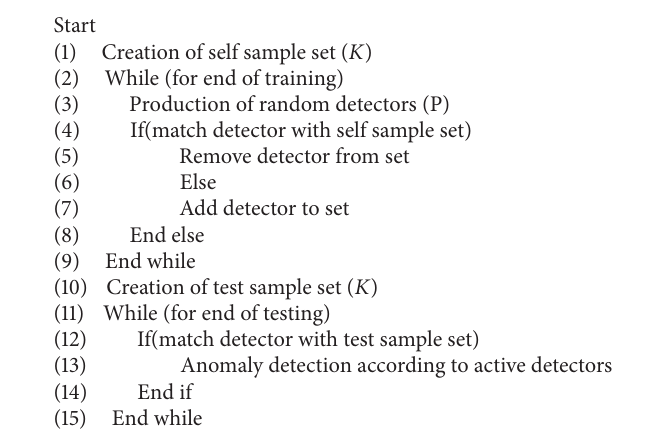
Pseudocode 2: The pseudocode of negative selection